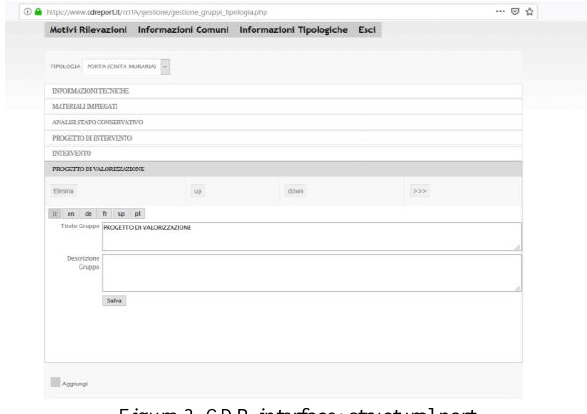
Figure 3. CDR interface: structural part